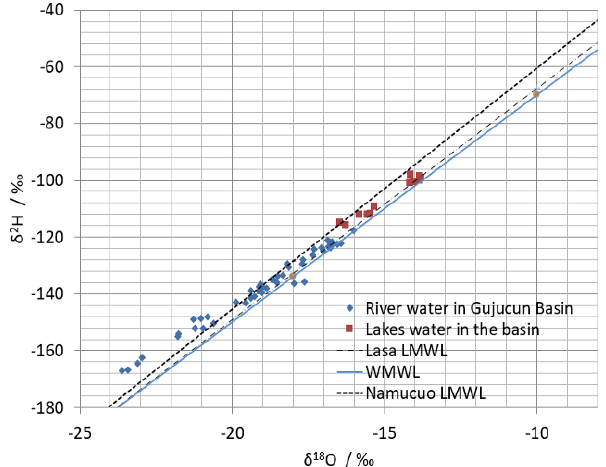
Figure 7. δ 2 H vs δ 18 O of the surface runoff water.